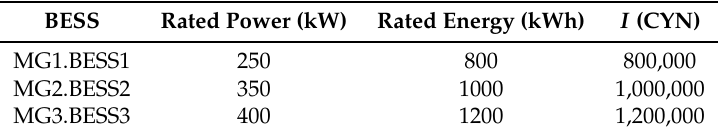
Table 2. Parameters of the battery energy storage systems (BESSs).